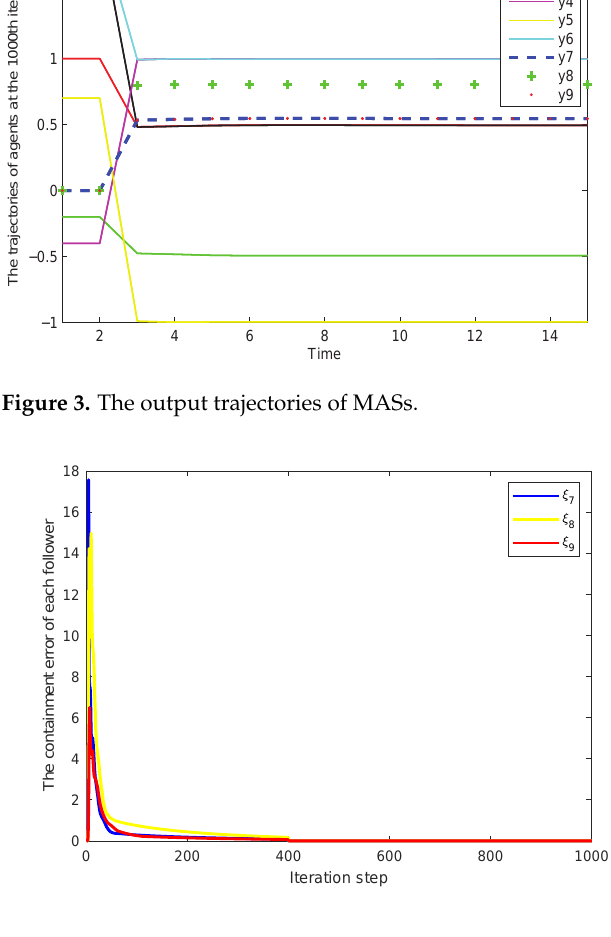
Figure 4. The containment